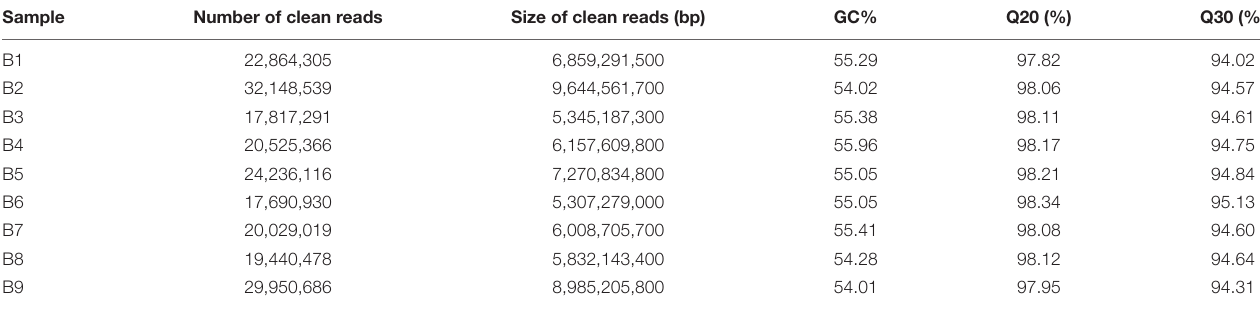
TABLE 1 | Sequencing the P. antidotale transcriptome in leaf from plants of control (B1, B2, and B3), low salinity (B4, B5, and B6), and high salinity (B7, B8, and B9) treatments.